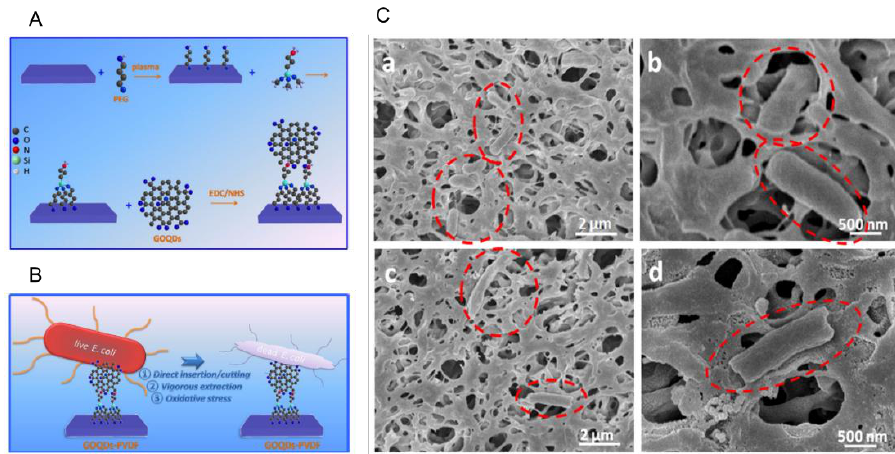
Figure 2. Antibacterial activity of polyvinylidene fluoride (PVDF)-modified graphene oxide QDs (GOQDs–PVDF). ( A ) Schematic illustration for covalent immobilization of GOQDs onto the PVDF membrane surface. ( B ) Bactericidal mechanism of GOQDs–PVDF. ( C ) SEM images for Escherichia coli at the surface of the PVDF membrane ( a , b ) and GOQDs–PVDF membrane ( c , d ). The bacteria (red circle) maintain their original structure ( a , b ), while they become compromised on the GOQDs–PVDF membrane ( c , d ). The images were reproduced with permission from Reference [26], Nature 2016.